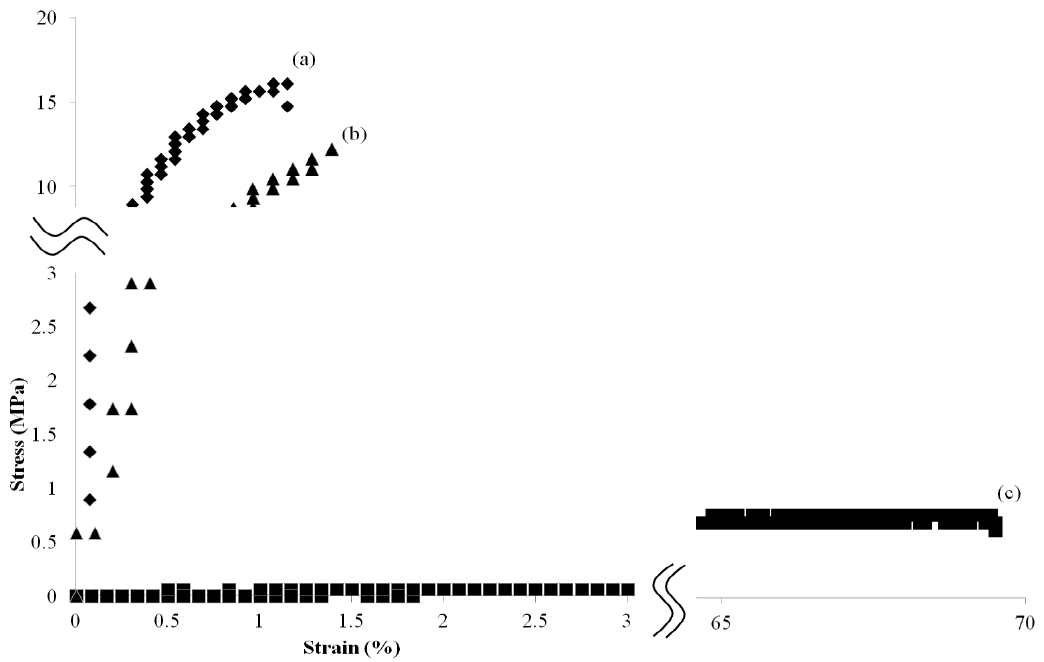
Figure 6. Stress-strain curves of CNF film ( a ); CNF- g -PMMA film (( b ), MMA; 5 equiv.); and PMMA film ( c